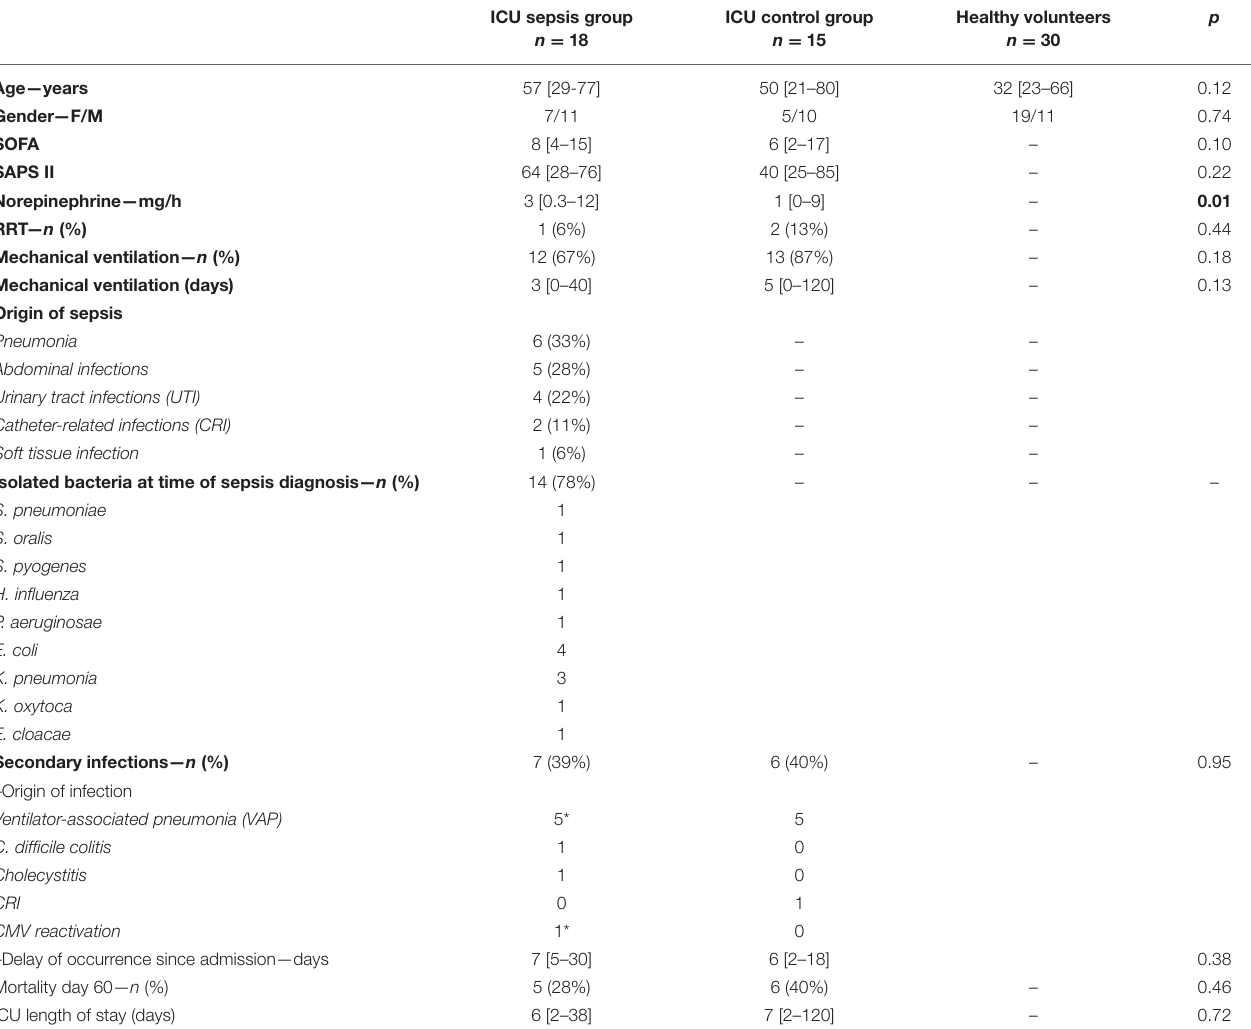
TABLE 1 | Patient characteristics, ICU-septic patients vs. ICU